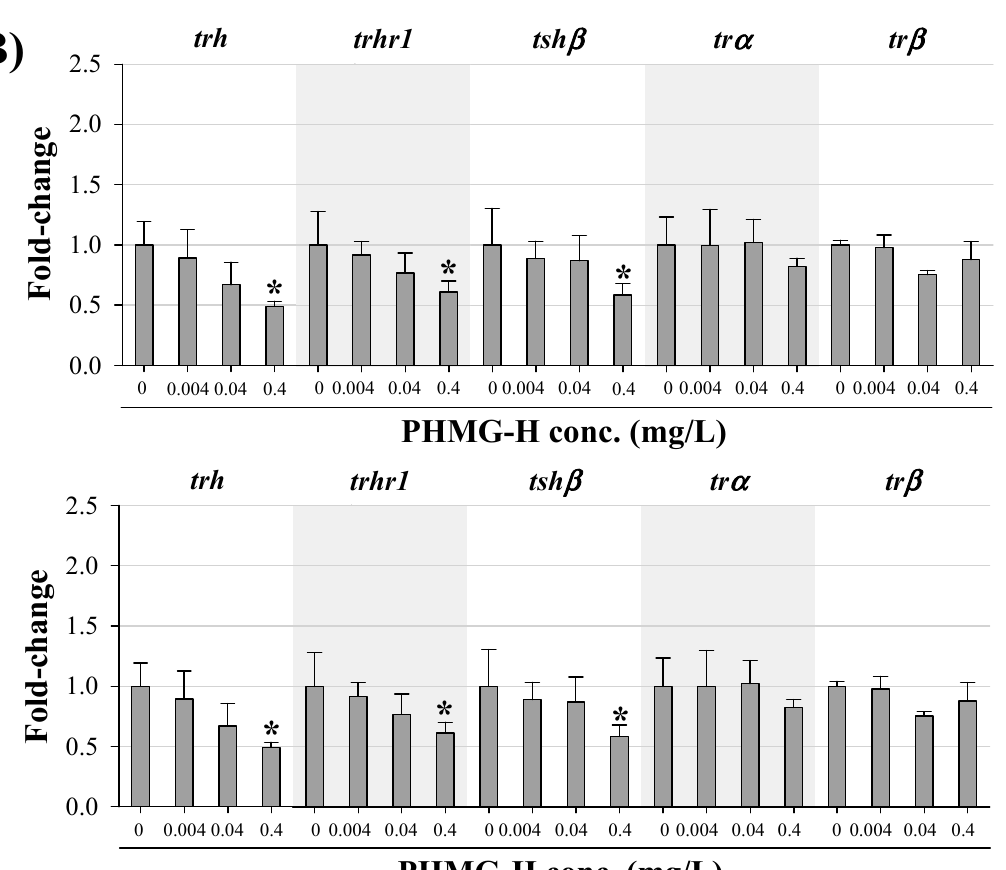
Figure 3. Transcription of genes related to the hypothalamus-pituitary-thyroid axis in zebrafish larvae after exposure to Vegetable HD ( A ) and PHMG-H ( B ) for 7 d. Fold change values of gene transcription are expressed as mean ± standard deviation of four replicates. Asterisk indicates significant difference from the control group ( p < 0.05).